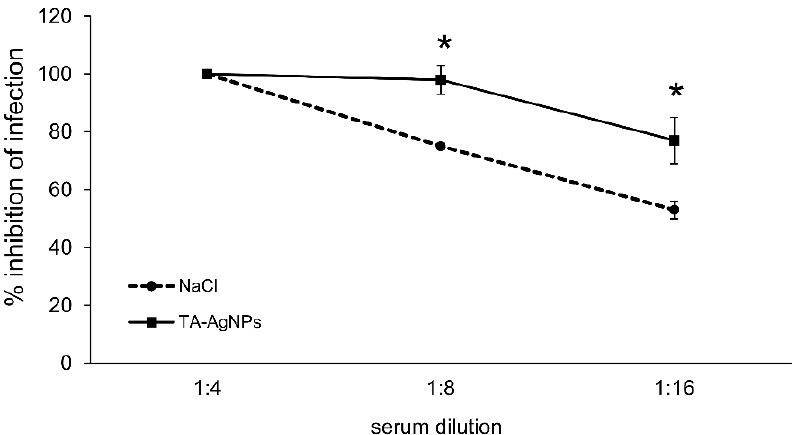
Figure 6. Intravaginal treatment with TA-AgNPs of HSV-2 infection induces better seroneutralization titers. The C57BL6 mice were infected intravaginally with HSV-2, and treated with 5 µg/mouse of TA- AgNPs, then re-challenged thirty days later with the same virus dose. Sera were taken at 10 days after re-challenge with HSV-2, and were subjected to seroneutralization tests. The means are expressed as mean ± SEM for n = 20; * represents significant differences with p ≤ 0.05.